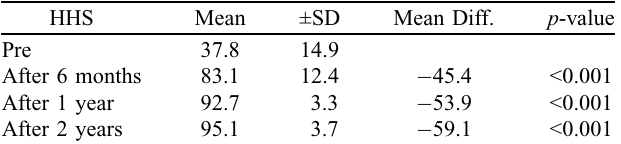
Table 2. Differences between the pre- and post-operative Harris